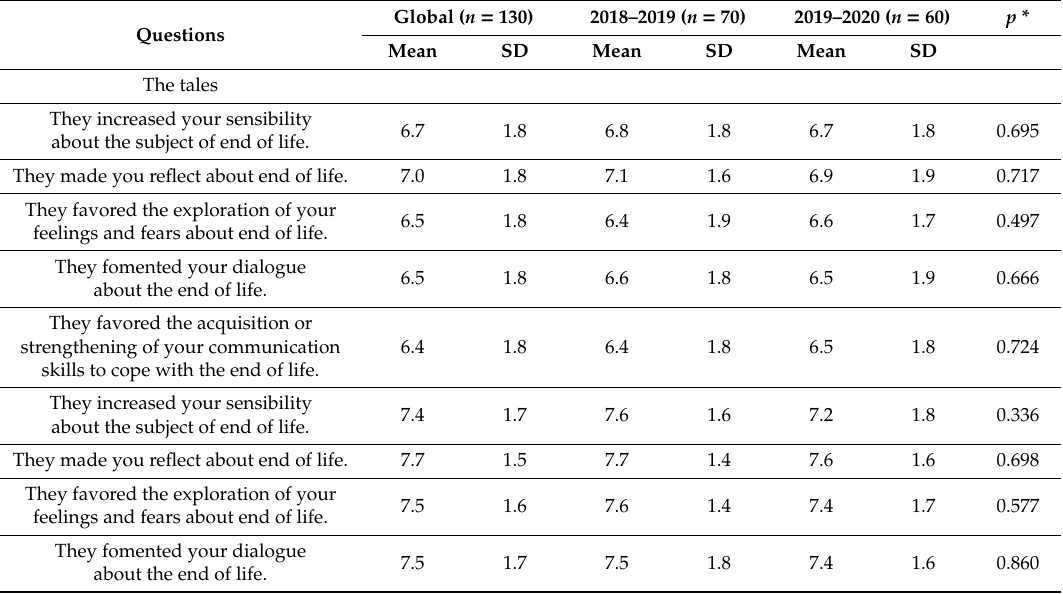
Table 3. Evaluation of the